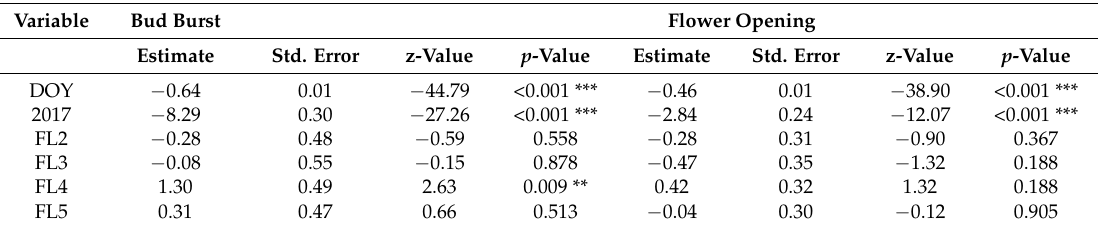
Table 3. Model statistics for the timing of bud burst and flower opening. The provenance FL1 and the year 2016 are the standard levels for the categorical variables provenance and year, to which the other year, 2017, and the other provenances are compared. DOY: day of the year. Provenance abbreviations are given in Table